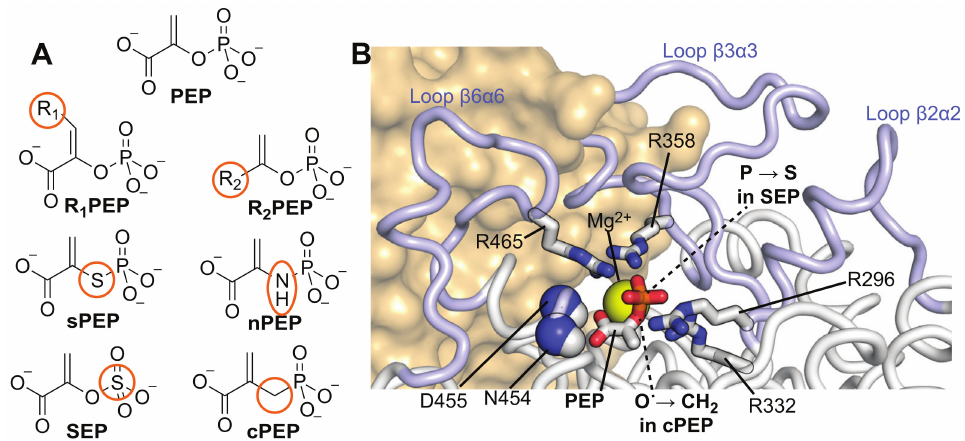
Figure 1. ( A ) Structural formulas of PEP and of common PEP analogues. ( B ) Close-up view of the active site of EIC in complex with PEP. The active site loops are shown as blue cartoons. The side chains of the active site Arg residues are shown as sticks (blue for nitrogen and white for carbon). The backbone amides of Asn 454 and Asp 455 are shown as spheres (blue for nitrogen and white for hydrogen). The Mg 2+ ion is shown as a yellow sphere. PEP is shown as sticks (red for oxygen, white for carbon, and orange for phosphorus). The position of the single atom substitutions to transition from PEP to cPEP (O → CH 2 ) and from PEP to SEP (P → S) are indicated by dashed lines. The second EIC subunit is shown as an orange